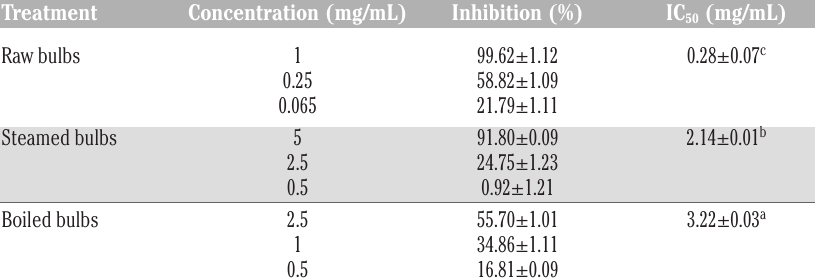
Table 3. Lipase inhibitory activity of extracts of raw and cooked lampascioni (Muscari comosum).